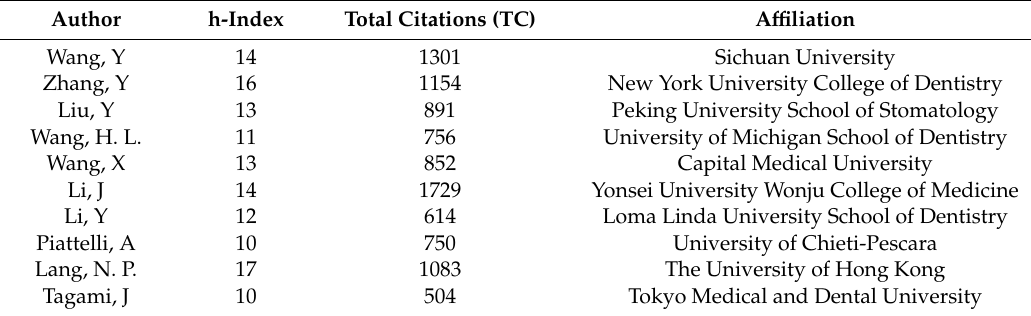
Table 6. Most Productive Authors’ h-indices and Total Citations.